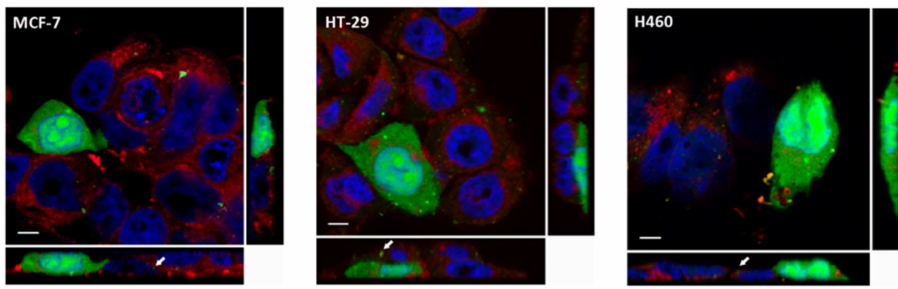
Figure 1. CIGB-552 (50 µ M, in green) is capable of penetrating the three cell lines, displaying two different internalization patterns: fully loaded cells and punctuated pattern (arrow) (scale bar = 5 µ m). Nuclei were labelled using TOPRO-3 probe (blue) and cell membranes were labelled with CellMask (red).